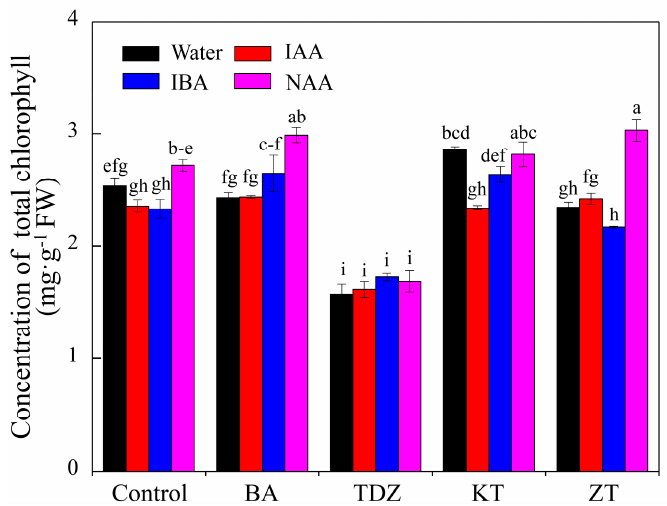
Figure 2. The effect of cytokinin and auxin on chlorophyll contents in strawberry leaves. FW: Fresh weight. Lowercase letters indicate significant differences calculated by Duncan’s multiple range test at p ≤ 0.05. Vertical bars indicate the standard error ( n = 3).